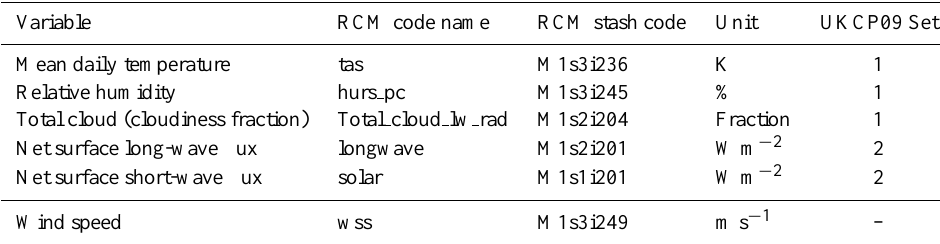
Table 2. HadRCM3-Q0 climate variables used to estimate PET for GB. Last column indicates the set of the UKCP09 probabilistic samples where change factors are